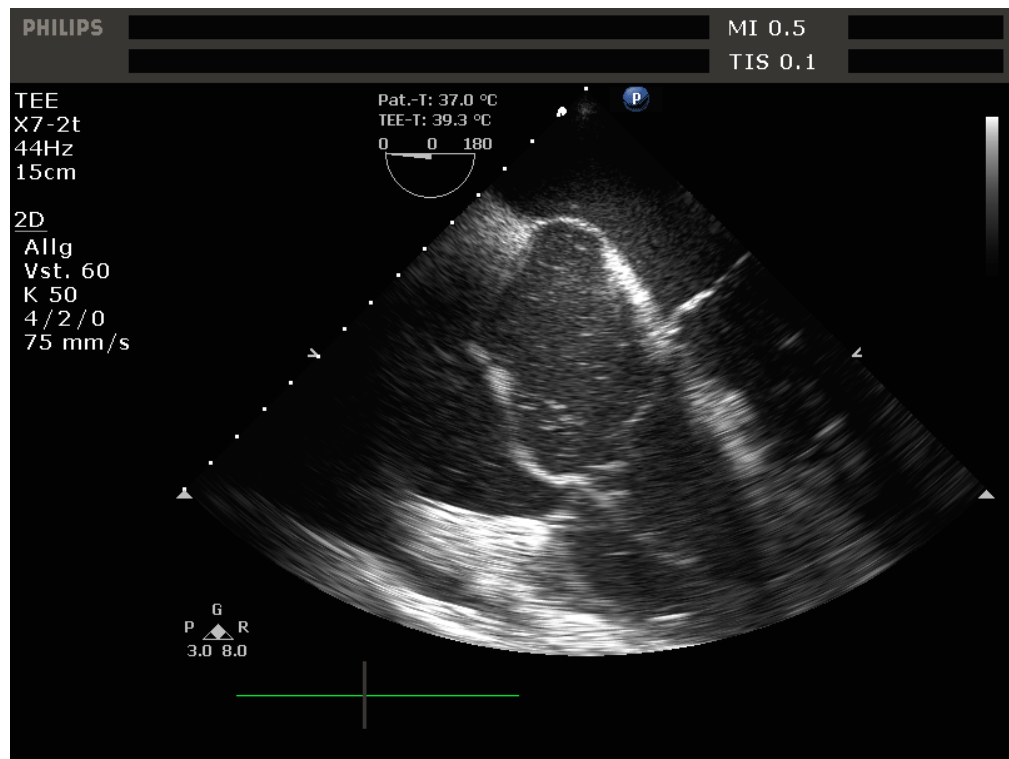
Figure 7. Transesophageal echocardiogram (midesophageal 4-chamber view) showing severe dilation of the right-sided cardiac chambers, bowing of the interatrial septum into the LV due to elevated right atrial pressures and a hyperechogenic structure in the RA and RV, in this case a clot in transit.